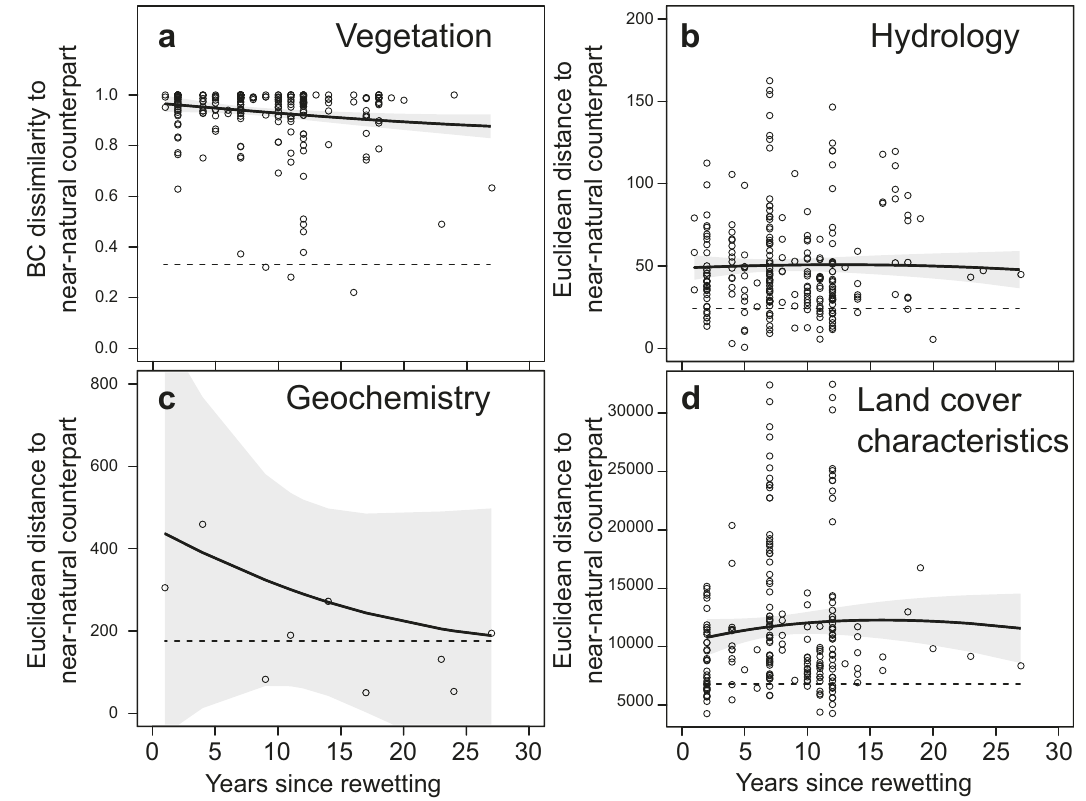
Fig. 4 Strong differences and little to no temporal trend in the pairwise dissimilarity between rewetted sites and near-natural counterparts of similar origin. Dissimilarity in unitless Bray – Curtis (BC) dissimilarity for the vegetation (0 = identical species composition, 1 = no shared species) and in Euclidean distance (0 to in fi nite) for the other response clusters between each rewetted site with a near-natural counterpart (same peatland origination, comparable altitude, same biogeographic zone, minimum spatial distance) against the time since restoration. Black lines indicate a LOESS spline with span = 1.4 (lowest span not leading to uninformative multiple local minima or maxima) and its 95% con fi dence interval shaded in gray. Horizontal dashed lines indicate the mean dissimilarity between pairs of near-natural sites selected the same way as the near-natural counterparts of the rewetted sites. Linear models indicate highly signi fi cant intercepts ( p < 0.001 for all four response clusters) and no signi fi cant slopes ( p > 0.6) except for vegetation ( p = 0.013). and we included only data if available for at least one full year. All water table measurements have been made in direct vicinity to the vegetation relevée. We considered the annual median water table, annual minimum water table, annual maximum water table, and annual amplitude of water table (max minus min) as relevant response parameters. Data for water tables during the growing season were highly correlated to the annual water table data (annual median versus median throughout summer and autumn: r ² = 0.89; annual median versus median throughout winter and spring: r ² = 0.94; annual maximum versus maximum throughout summer and autumn: r ² = 0.85; annual maximum versus maximum throughout winter and spring: r ² = 0.86; annual minimum versus minimum throughout summer and autumn: r ² = 0.91; annual minimum versus minimum throughout winter and spring: r ² = 0.73). (3) Geochemistry: pH and electrical conductivity of the pore water (0 – 60cm), bulk density and organic matter content of the top soil layer (0 – 30 cm) the center plot location of the site. Different spatial aggregations (e.g., single sampled in summer for all sites included here alongside the vegetation data pixels, 5×5 pixels around the center plot) led to highly similar results, sampling. The parameters considered for geochemistry and also for implying that the intra-site variability was robust around locations of the hydrology had to be chosen in order to maximize data availability in vegetation survey. The inclusion of an annual series of Sentinel-1 synthetic parallel with meaningfulness. Note that, still, geochemical data are only available for a subset of the full data set (57 sites; see Fig. 3e – h for sample size per group). Despite the low sample size, it is important to note that the The representativeness of our database is con fi rmed by the comparison to 10k remaining sites cover almost the whole geographical range of the other vegetation plots from all over Europe. These have been randomly chosen response parameters (Eastern Poland, Eastern and Northern Germany, the from > 90k vegetation plots of the European Vegetation Archive 46 , classi fi ed as Netherlands, Belgium, Wales) and no geographical or ecological bias was belonging to peatland types (Q2: “ Poor fens ” , Q4: “ Calcareous rich fens ” , Q5: “ Tall found. In addition, the remaining sites contain well-comparable pairs of helophyte beds ” , Qa: “ Mires ” ) of the EUNIS habitat types 18,28 . Plant taxa have been rewetted and near-natural sites throughout this geographical space. While standardized to Euro + Med plantbase 47 and the checklist of bryophytes of the selected parameters allow for relevant insights, more speci fi c response Europe 48 and harmonized to exclude nested taxa (option maxtaxtable = ‘ AG1 ’ and parameters are required for process-based understanding of the biogeo- ag = ‘ con fl ict ’ in function taxval in R package vegdata 49 ). chemistry of rewetted peatlands 42 . (4) Land cover characteristics: spectral-temporal metrics for a full annual time Statistical analyses . An ordination (non-metrical multidimensional scaling, series of Copernicus Sentinel-2 A/B data for 2018. The Sentinel-2 A/B Bray – Curtis distance and step-across dissimilarities for those plot distances without constellation provides optical imagery of the Earth ’ s surface between common species with function ‘ metaMDS ’ from R-package ‘ vegan ’ 2.5-6) was NATURE COMMUNICATIONS| (2021) 12:5693